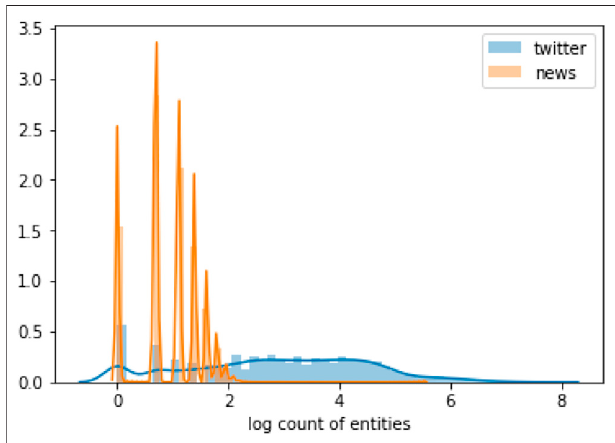
FIGURE 4 | Normalized histogram of the log count of entities in tweets vs. news